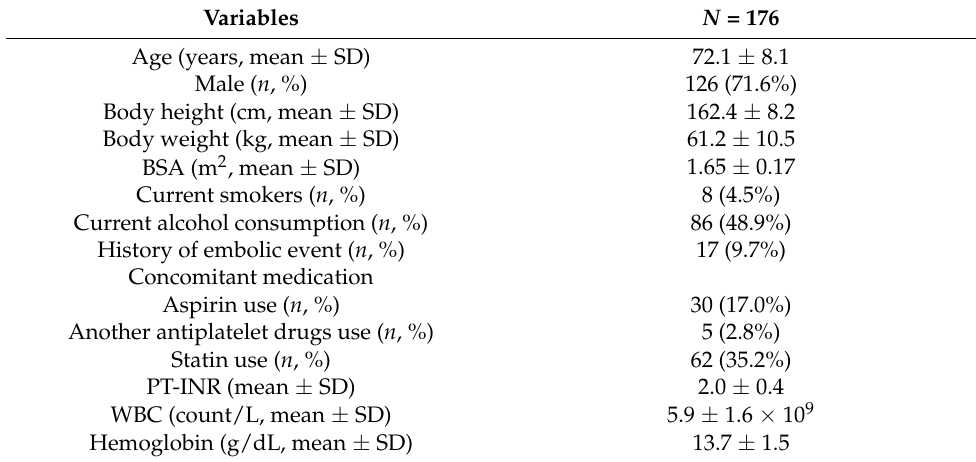
Table 1. Patient